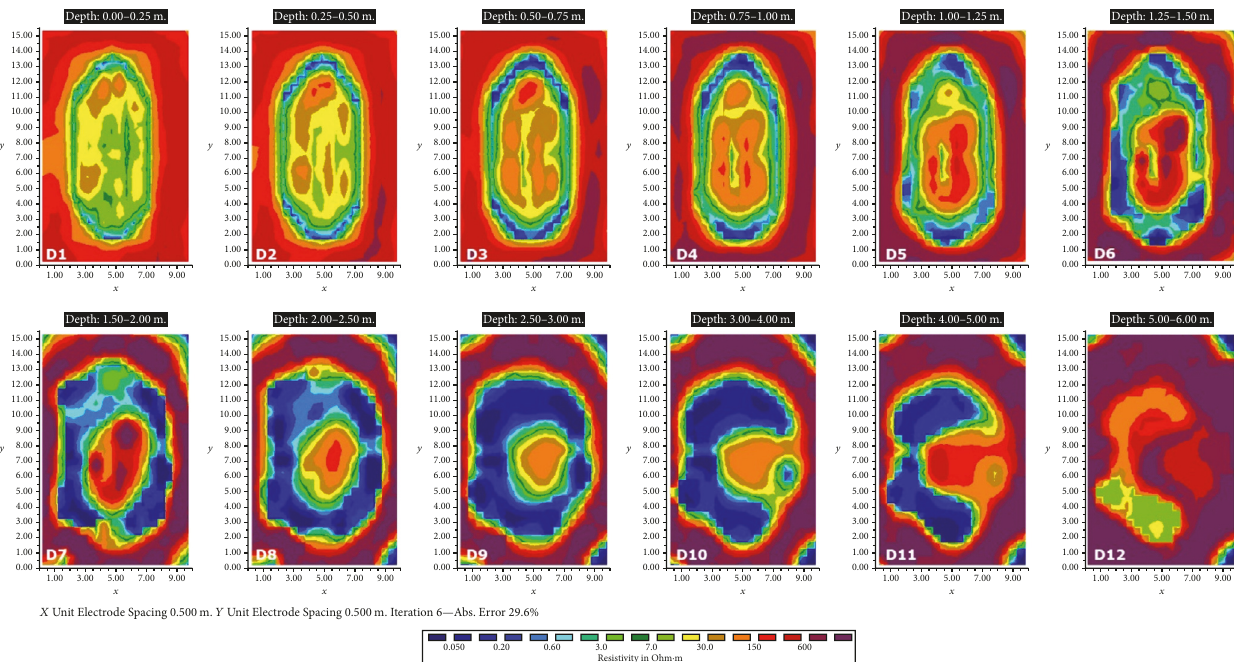
Figure 4: 3D inversion depth slices. Resistivity values mapped on a logarithmic scale. Both axes are given in meters.